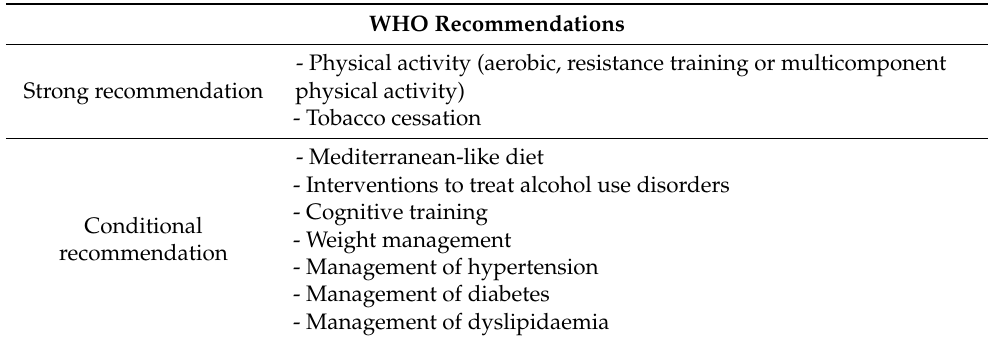
Table 1. WHO recommendations for risk reduction in cognitive decline and dementia (source: own illustration according to World Health Organization,